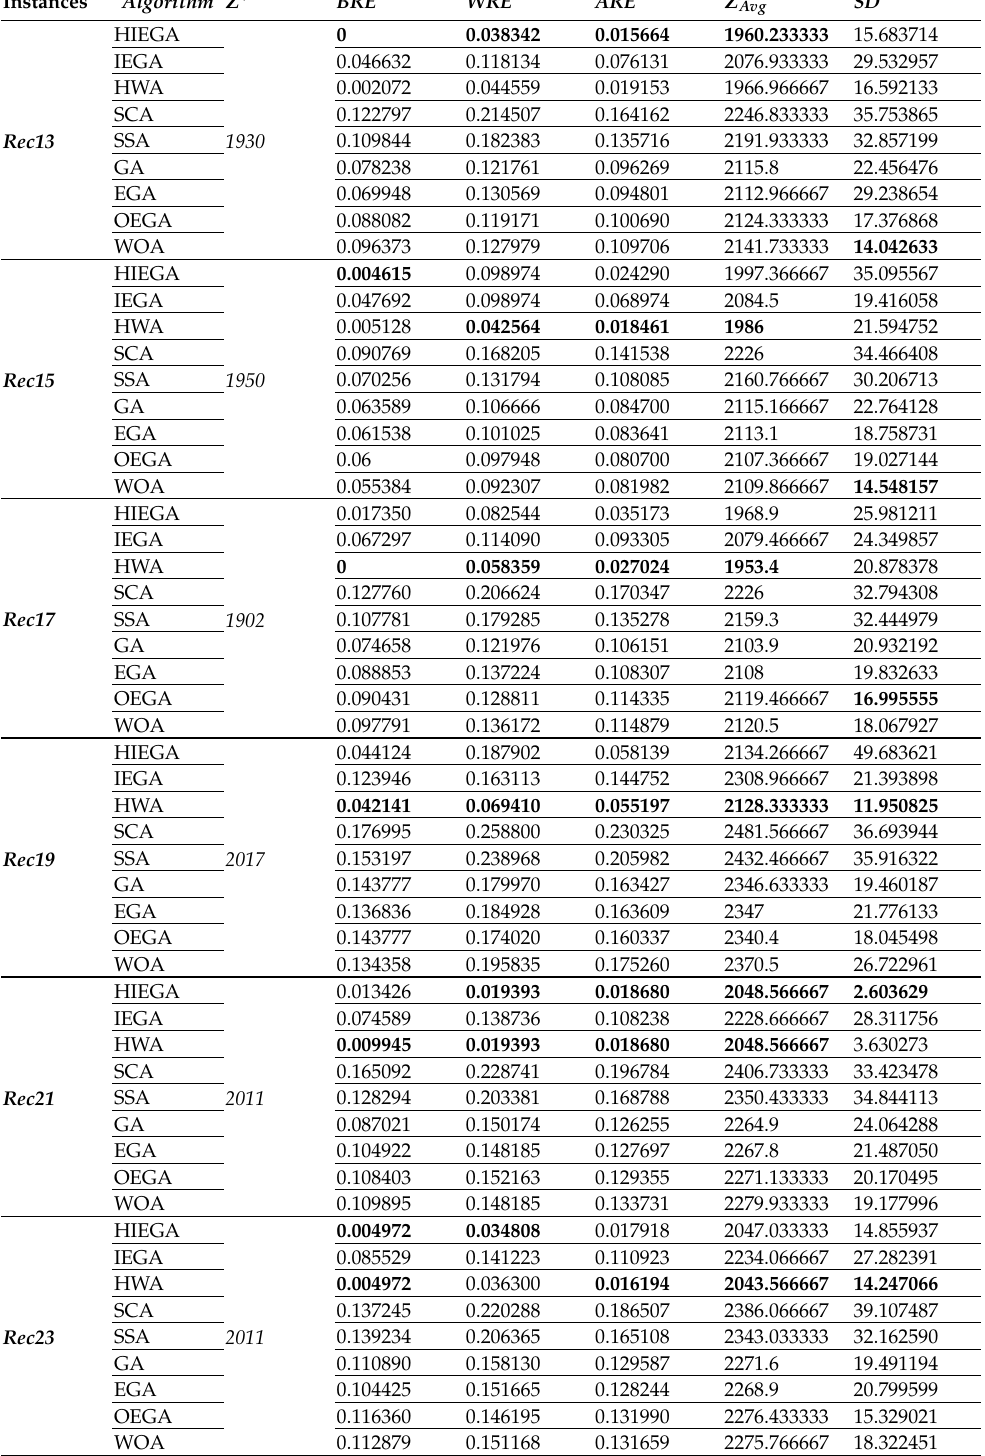
Table 6. Outcomes of different performance metrics on the Reeve instances